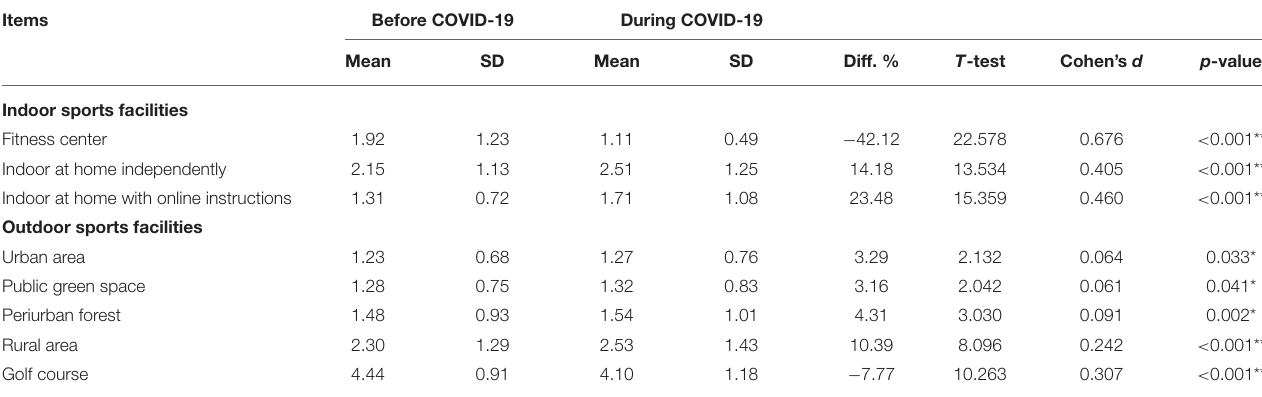
TABLE 2 | Frequency of physical activity at specific outdoor sports facilities before and during the COVID-19 pandemic among golfers ( n = 1,115). Items Before COVID-19 During COVID-19 Mean SD Mean SD Diff. % Cohen’s d